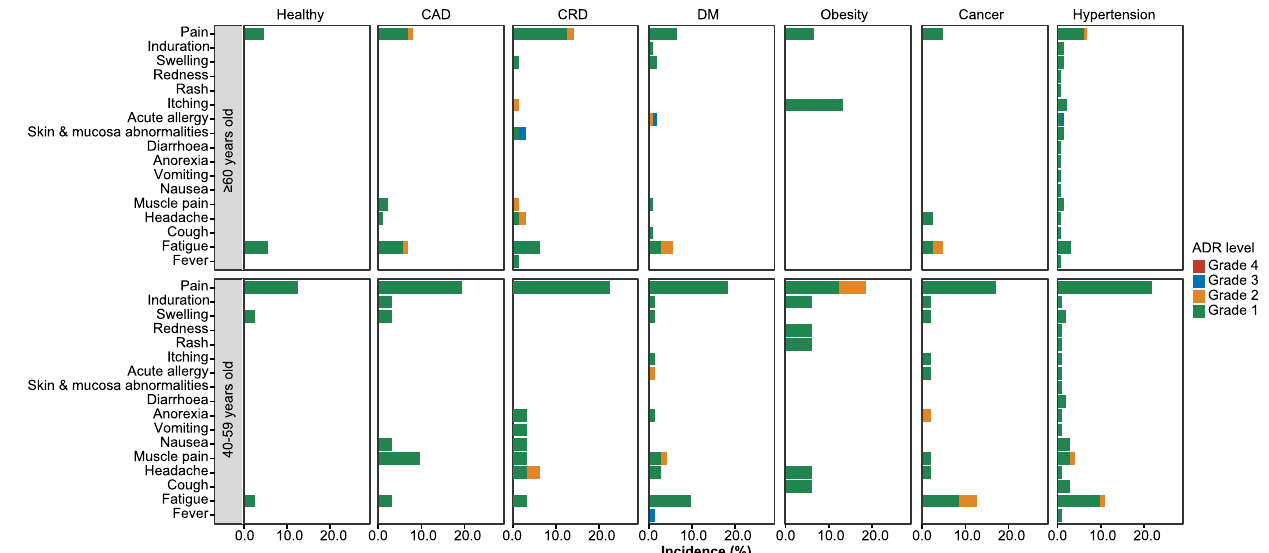
Fig. 2 Incidence of adverse events reported within 14 days post the fi rst dose and the second dose of the vaccination in the safety population, across age groups. n = 969 study participants. Adverse events post 14 days of fi rst dose and the second dose of the vaccination were collected and graded according to the China National Medical Products Administration guidelines. The histogram shown the incidence of adverse events happened in the 40 – 60 and ≥ 60 years old groups. Green, grade 1; orange, grade 2; blue, grade 3; Red, grade